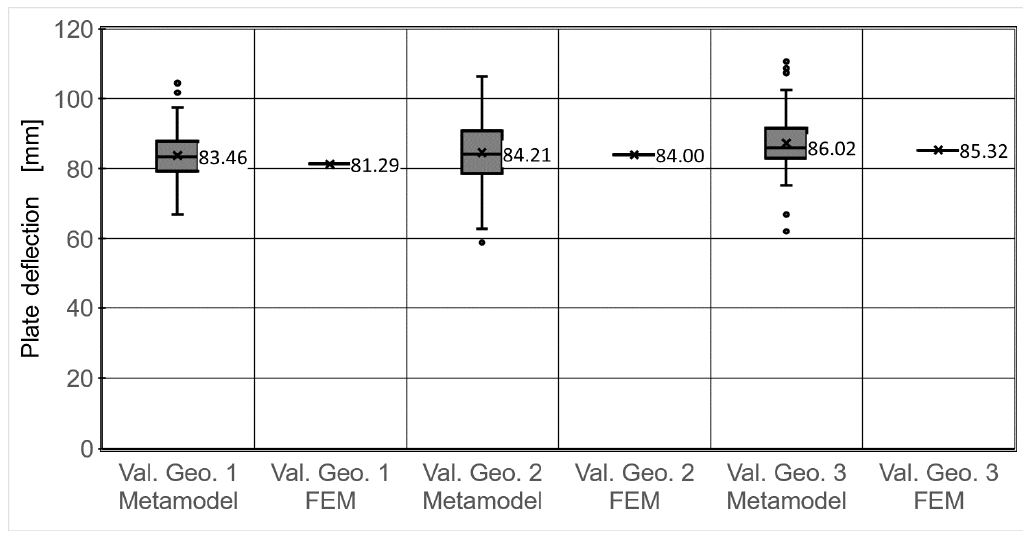
Figure 7. Comparison of plate deflections for the three preform validation geometries obtained by the metamodel and FEM.